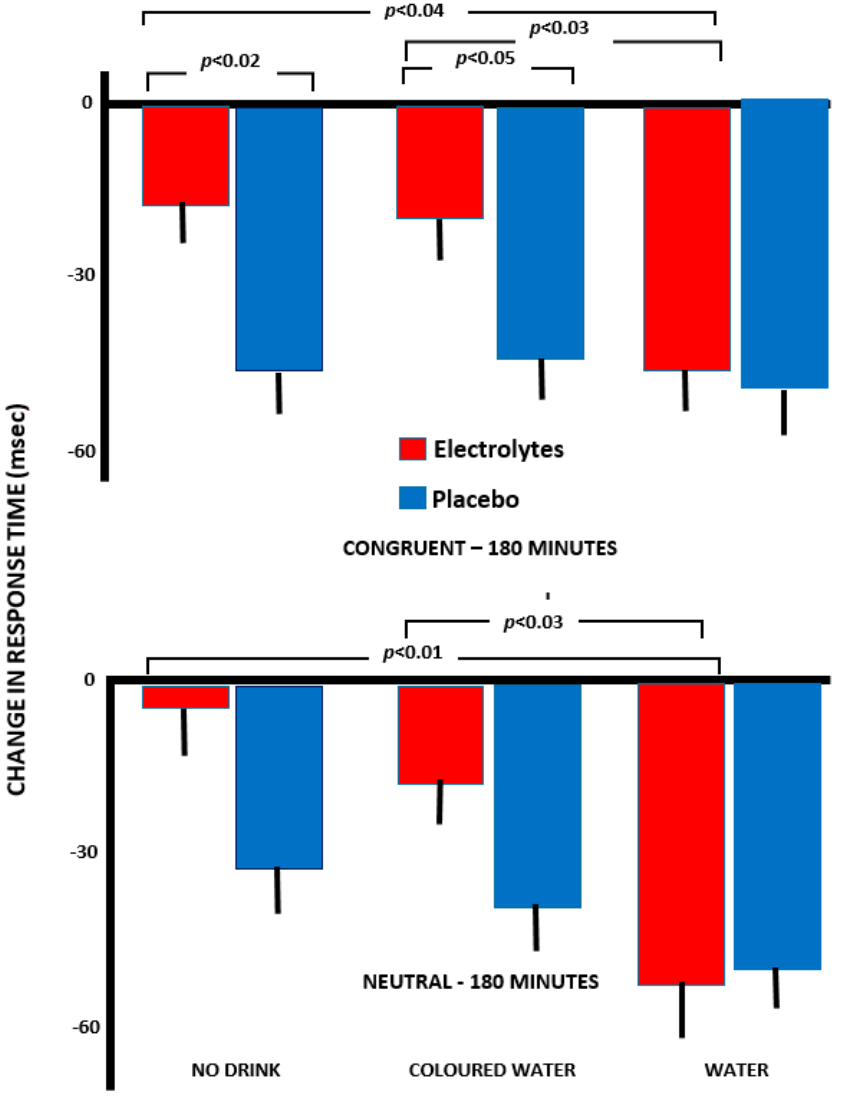
Figure 4. Changes in response times for neutral and congruent trials of the arrow flankers task. The scores are in milliseconds and are changes from baseline values. A lower negative number indicates faster response times. The data are means +/ − standard error.